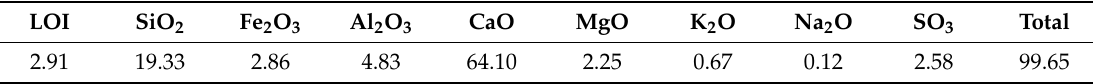
Table 2. Chemical composition of Portland cement (%).